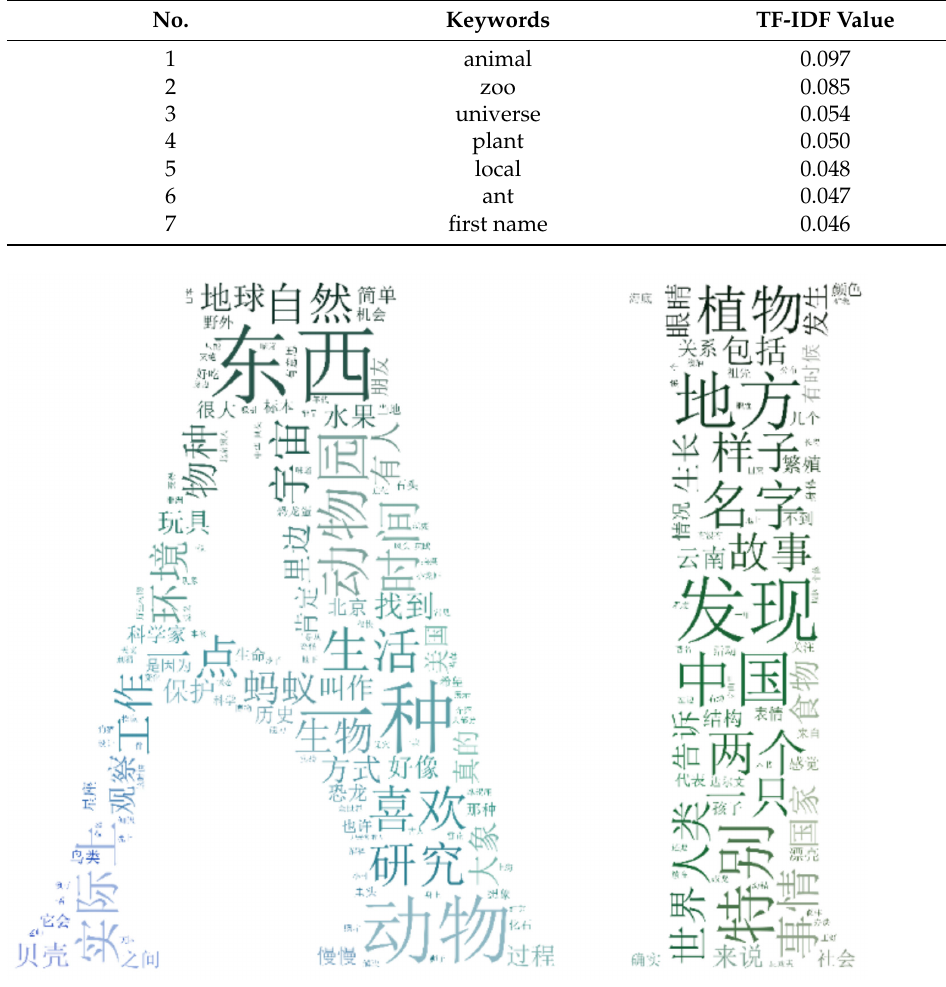
Table 2. Keywords of “Natural history” category from YiXi talks.